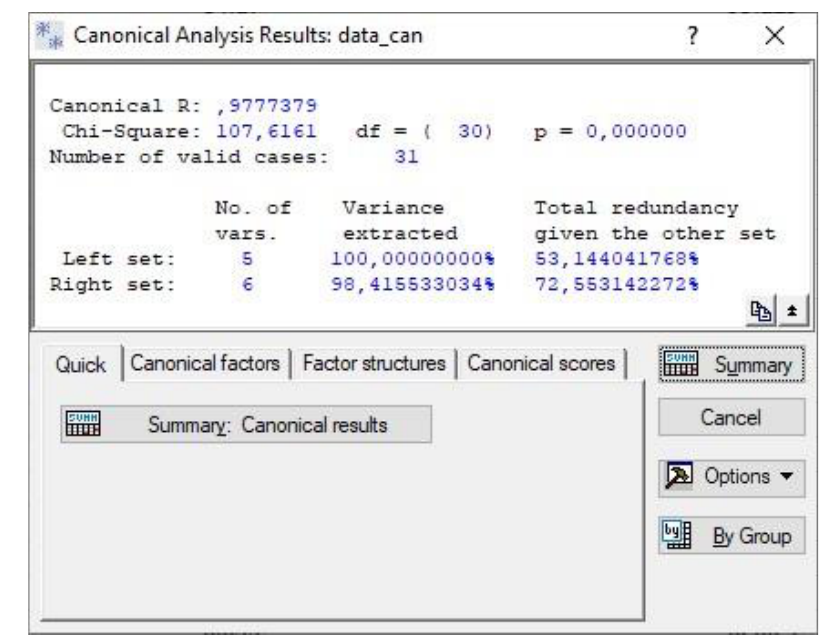
Figure 1. The Results of Canonical